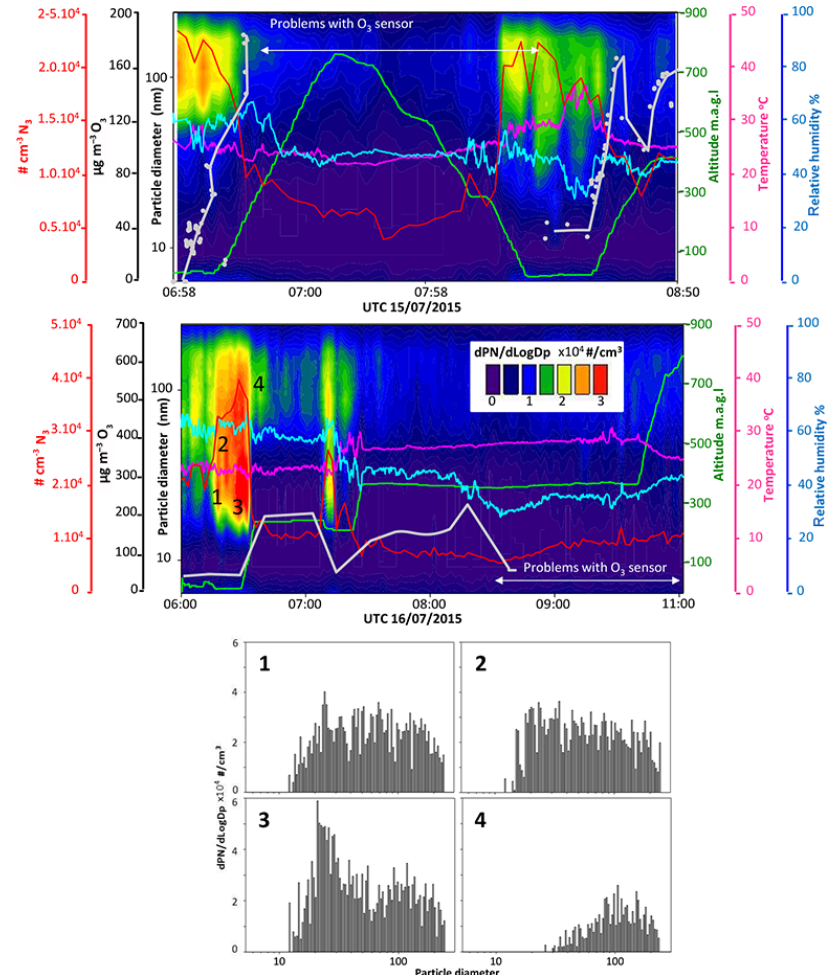
Figure 12. Time variation of altitude, temperature, relative humidity, N 3 , particle number size distributions and O 3 concentrations during the tethered balloon measurements on 16 July 2015. 1–3 illustrate the nucleation episode recorded at surface level with particle number size distributions, and 4 the typical regional background N size distribution at about 300m above